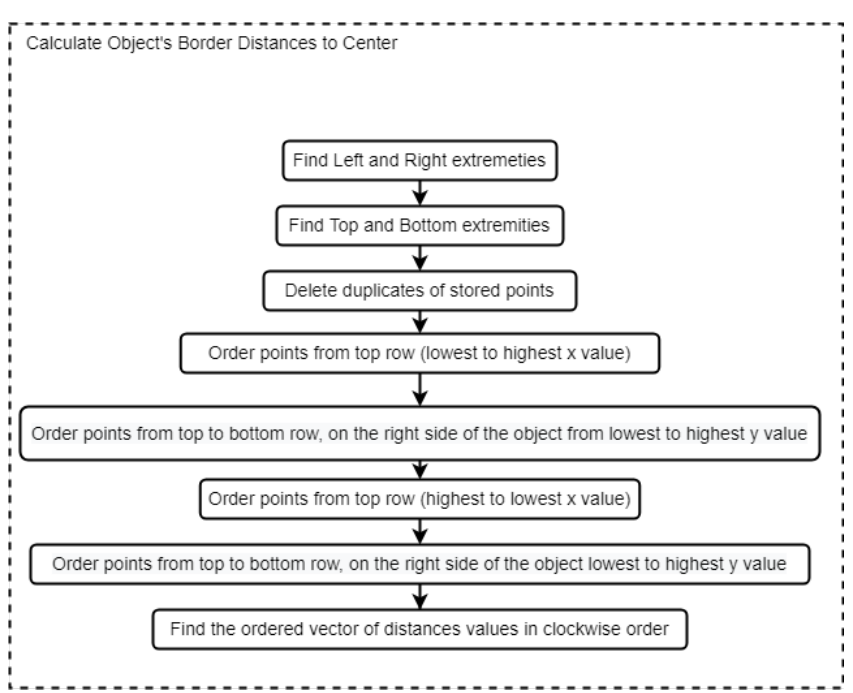
Figure 17. Center-point